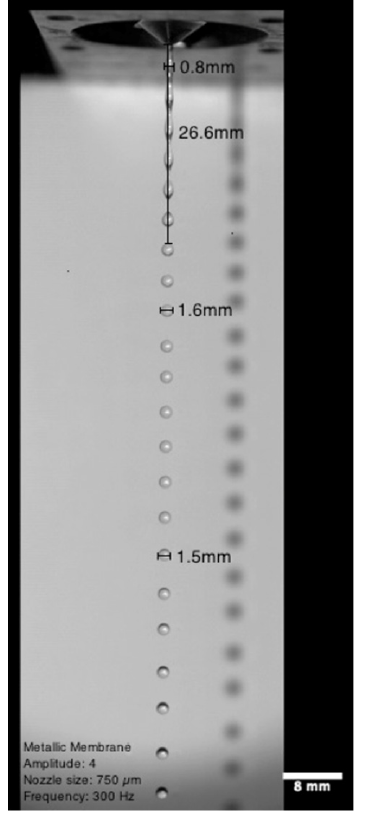
Figure 2. Monitoring of a jet capillary breakage.